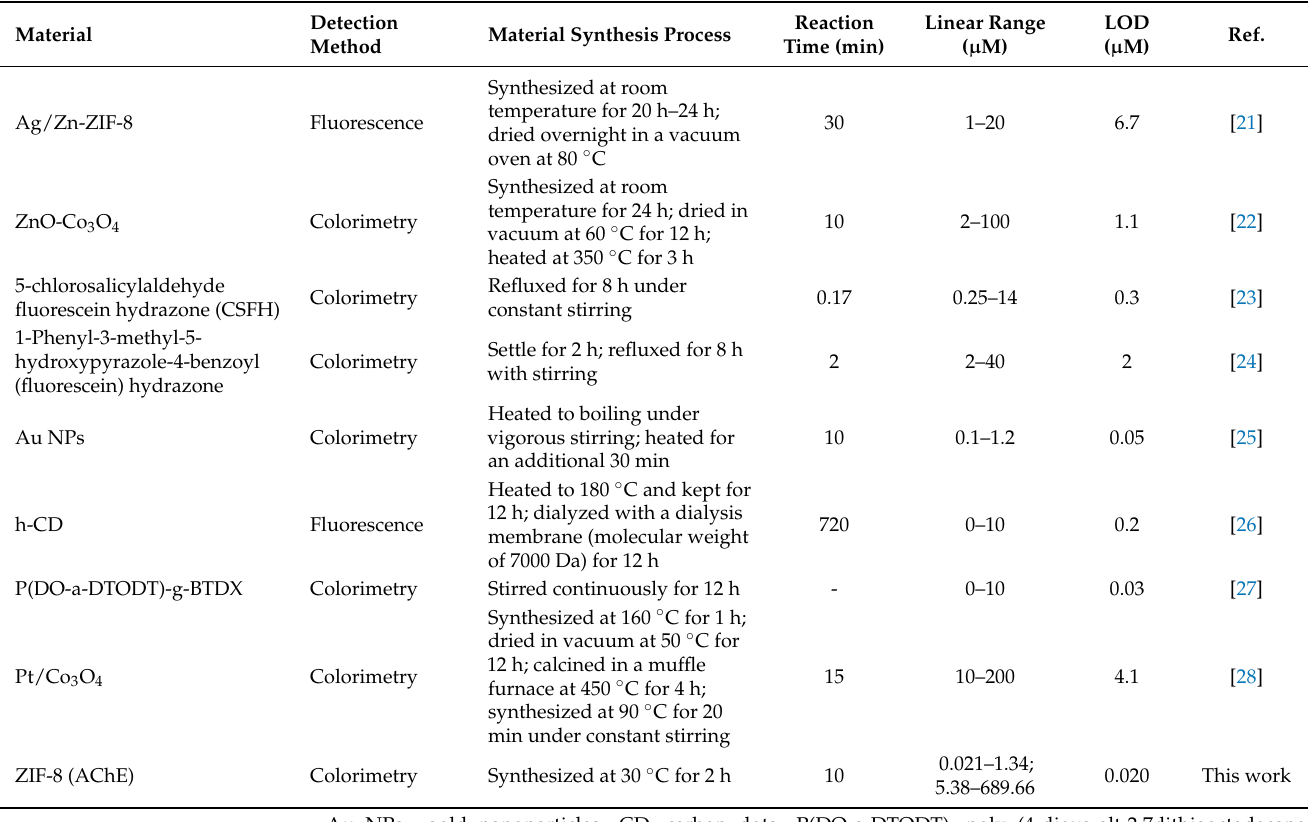
Table 1. Comparison of the previously reported methods and present work for the detection of Cu 2+ .